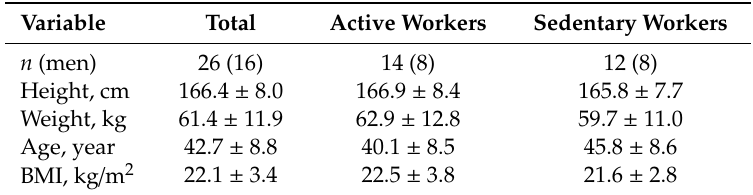
Table 1. Participants’